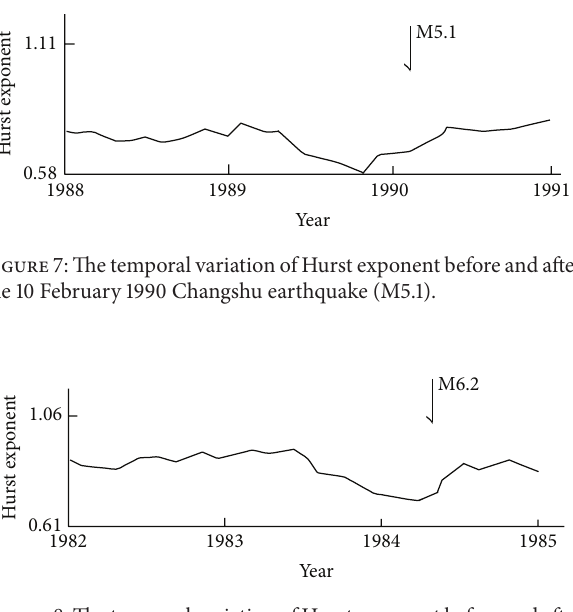
Figure 6: The temporal variation of Hurst exponent before and after the 26 July 1994 Yellow Sea earthquake (M5.3).